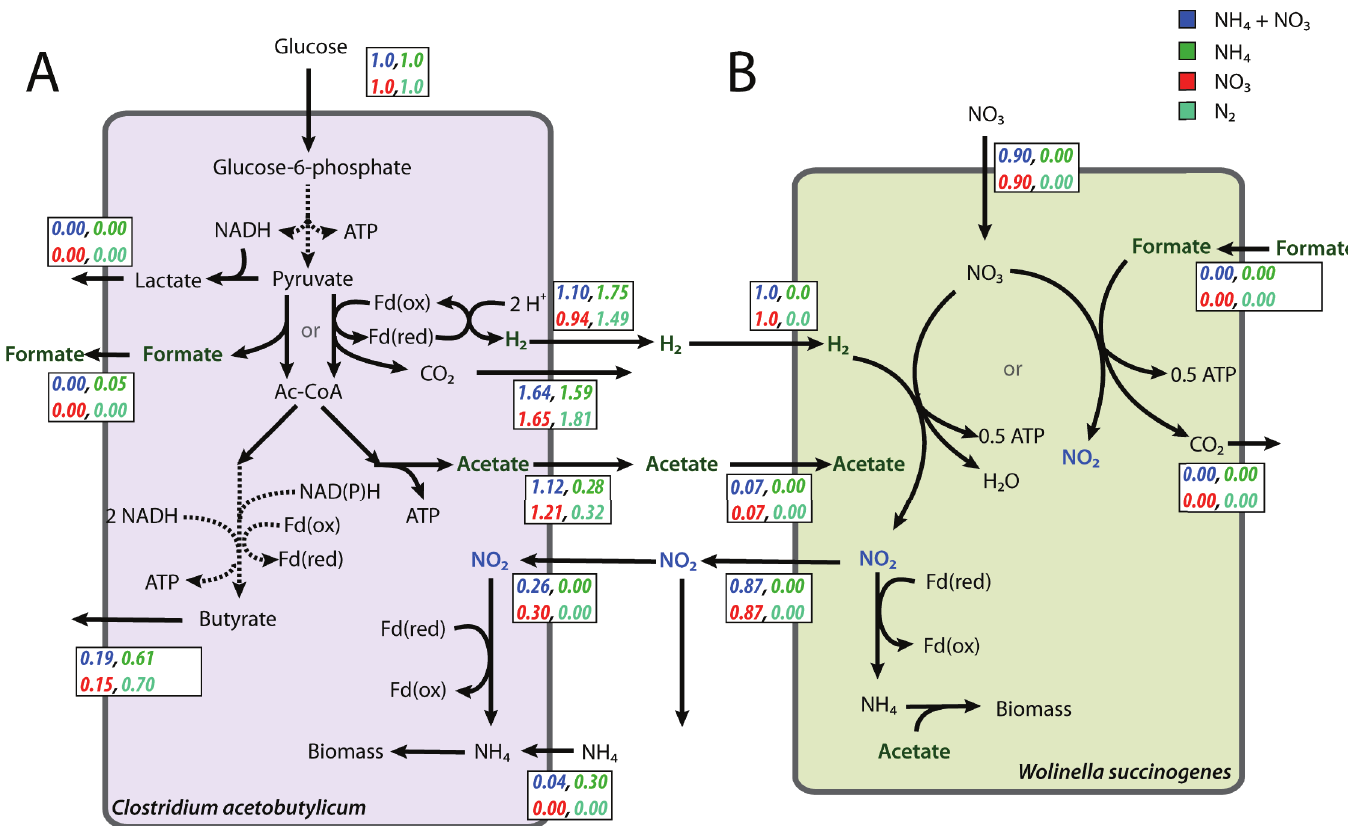
Fig 5. Nitrogen-source also had an impact on the H 2 and the NO 2- exchange rates. In A the calculatedflux-values for C. acetobutylicum are normalized for the glucoseuptake. B shows the calculatedflux-values for W. succinogenes and are normalized for the H 2 uptake. Note that H 2 productionby C. acetobutylicum is not equalto the specific H 2 uptake rate of W. succinogenes as the biomassabundancesshould be taken into account, which were not equal duringthe